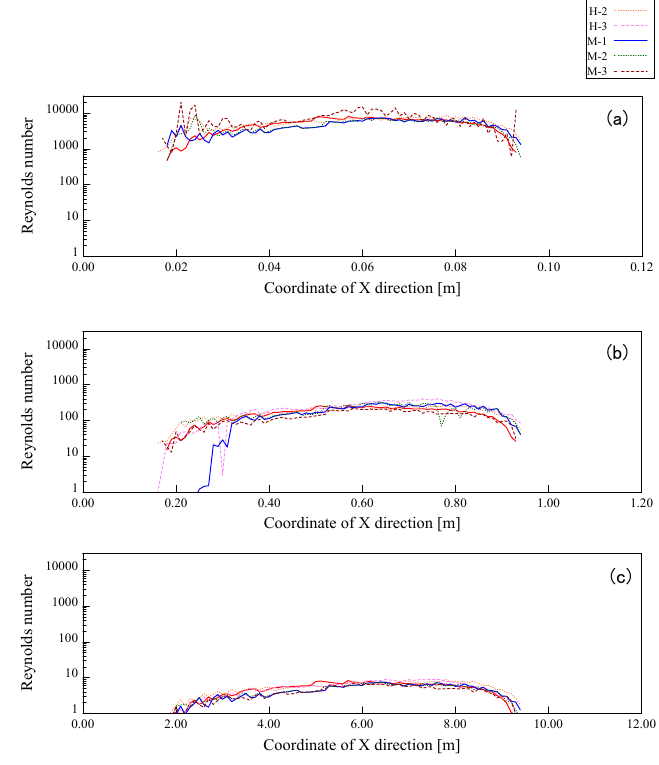
Figure 26. Relationship of Reynolds numbers in each cross section using the viscosity coefficient obtained from the simulation result: ( a ) the mesh size is 1mm; ( b ) the mesh size is 10 times; ( c ) the mesh size is 100 times.